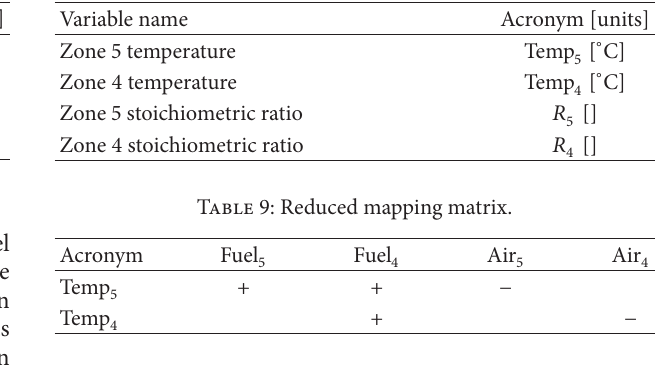
Table 10: Reduced Decoupling Matrix 𝐷 𝐸